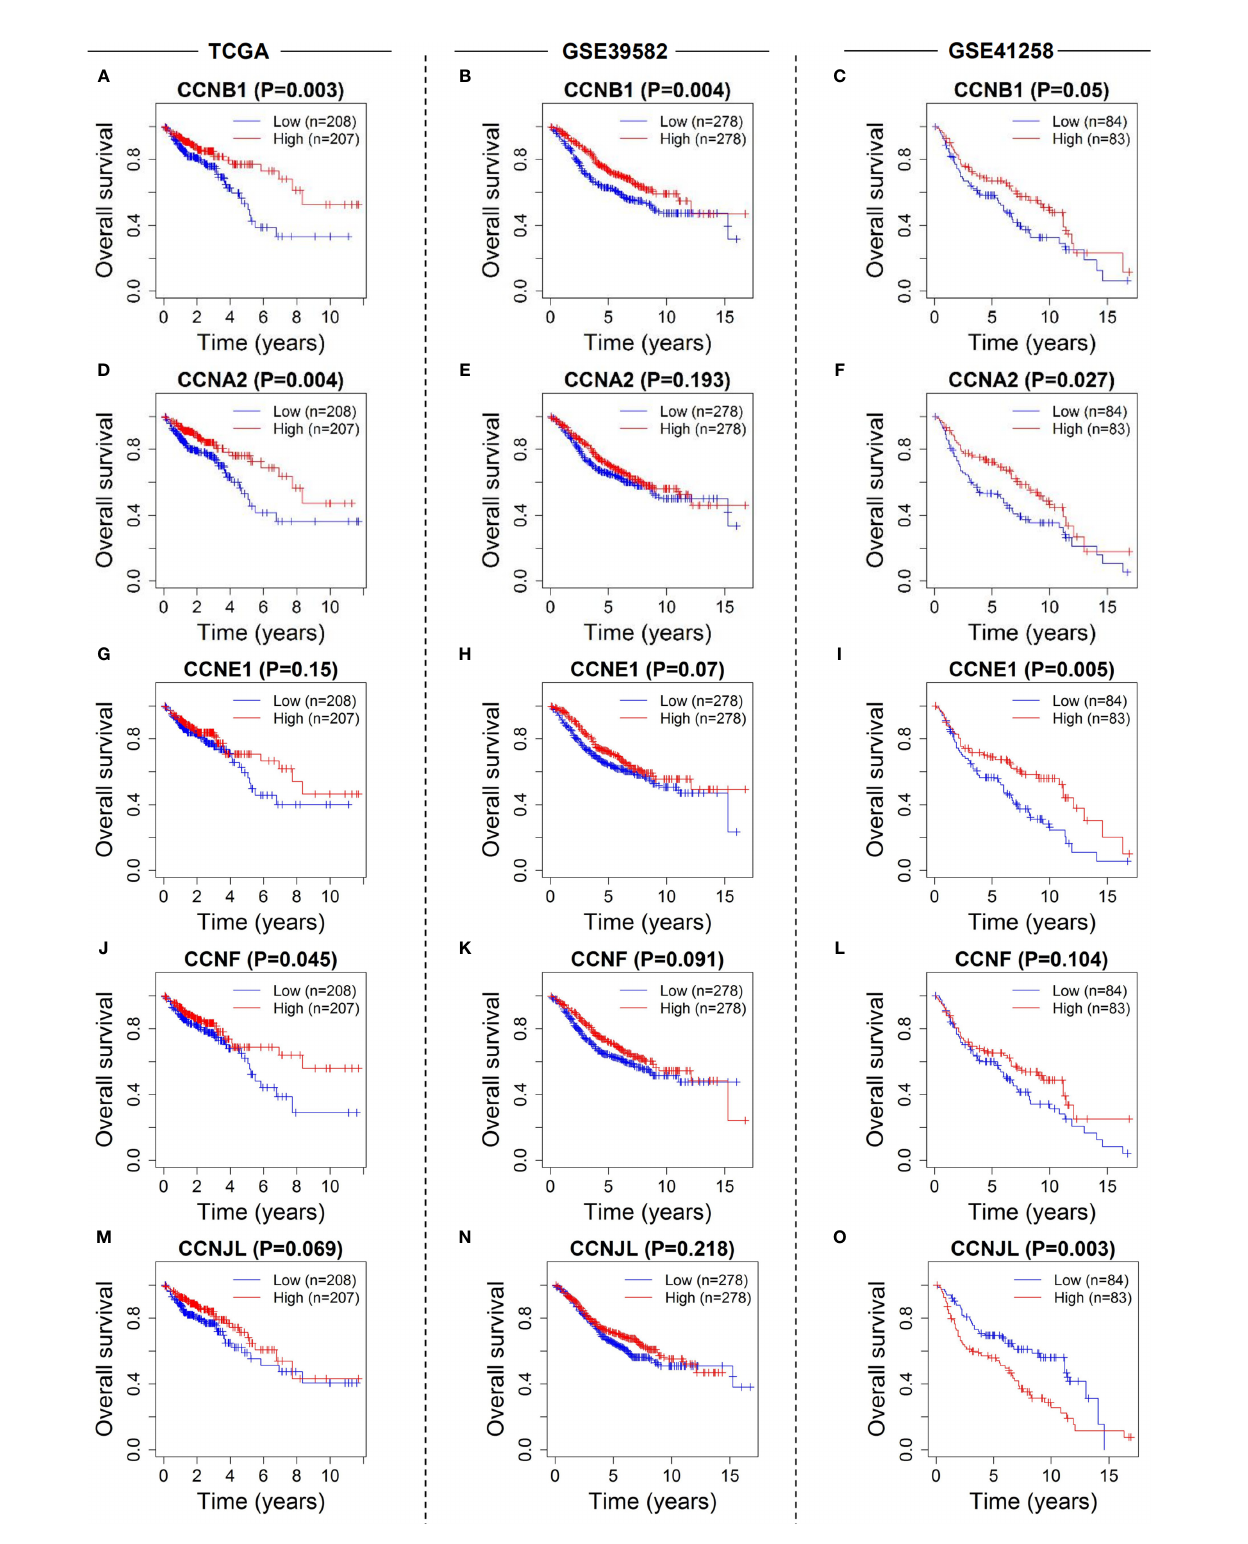
FIGURE 6 | Survival analysis of the six cyclin DEGs in patients with colon cancer in the three datasets. Kaplan-Meier survival curves showed that expression of CCNA2 (A – C) , CCNB1 (D – F) , CCNE1 (G – I) , CCNF (J – L) , and CCNJL (M – O) was signi fi cantly related to patient survival. For CCND1 , see Supplementary Figures 2D-F